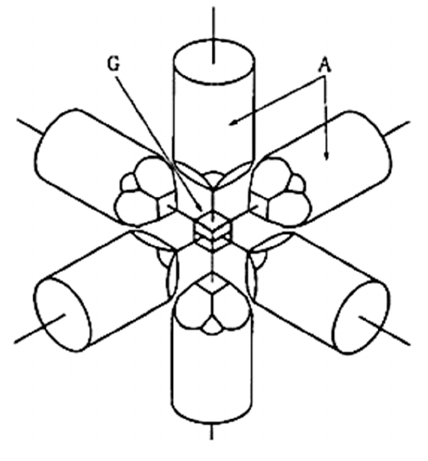
Figure 3. Schematic of the hexahedron anvil press.